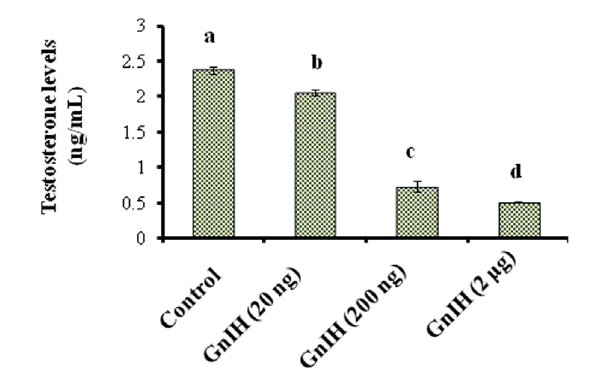
FigUre 1 | The mice treated with different doses (20, 200 ng, and 2 μ g/day) of gnih on synthesis of testosterone in testis of mice. GnIH showed significantly decreased ( p < 0.05) synthesis of testosterone levels in dose-dependent manner as compare to control (a, p <